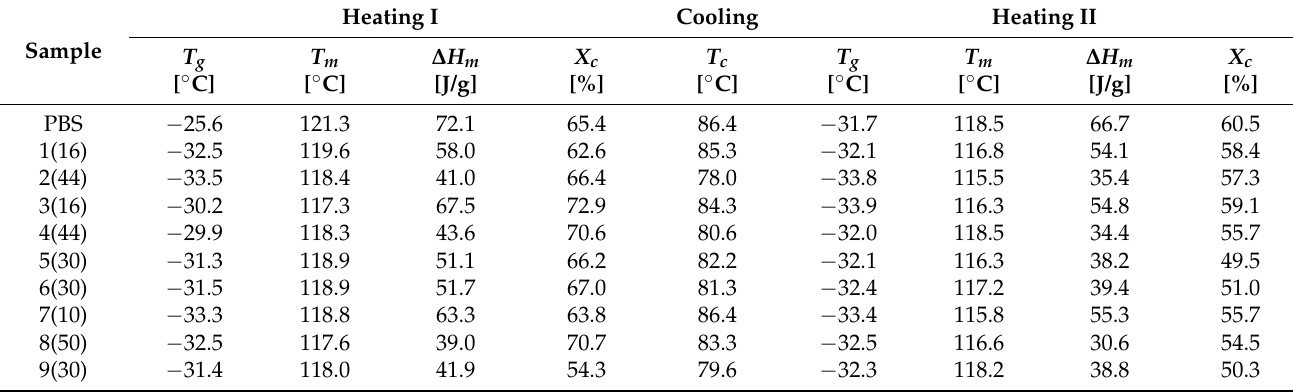
Table 7. Melting point ( T m ), crystallization ( T c ), and glass transition ( T g ) temperatures; the enthalpy of melting ( ∆ H m ) and degree of crystallinity ( X c ) of PBS and its composites with bran, based on differential scanning calorimetry (DSC)